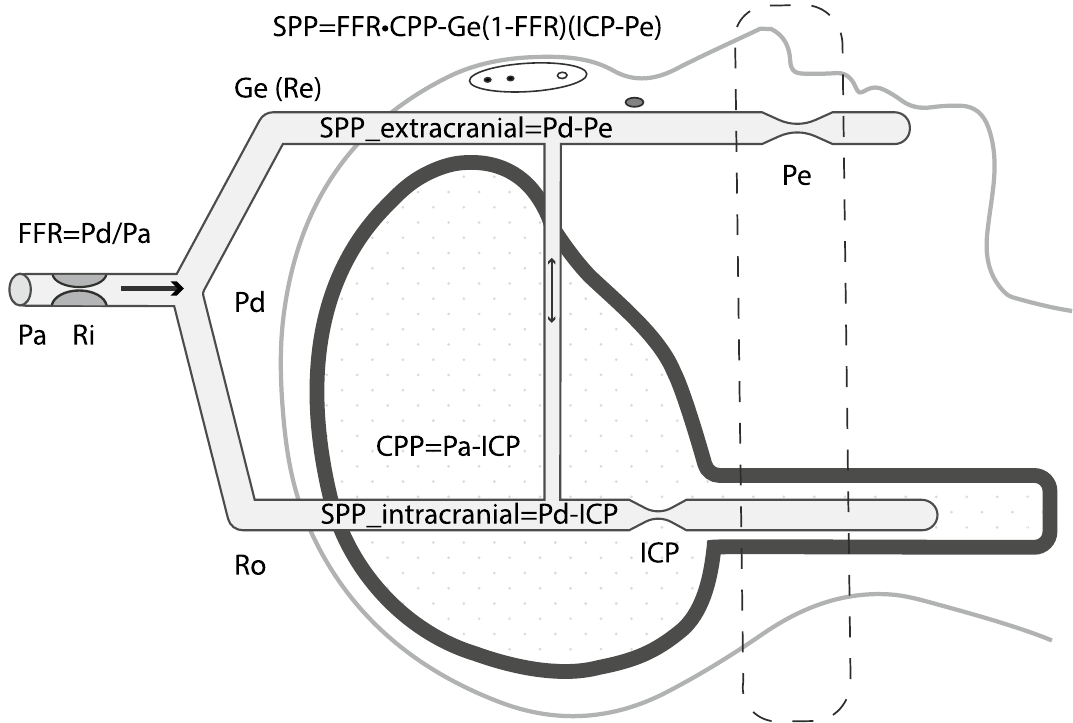
Figure 1. Schematic representation of intra-extracranial flow distribution. Despite the multitude of arterial and venous extra-intracranial supply pathways and anastomoses, all blood flow to the head is divided into the intracranial and extracranial, with corresponding compartmental pressures ICP and Pe. Extracranial compartment pressure is either atmospheric or venous (whichever is higher). Common inflow pressure Pd (equilibrated at the circle of Willis) is lower than systemic pressure Pa due to the common inflow resistance Ri—which determines fractional flow reserve- FFR. Pd can be estimated by measuring pressure in the intra- extracranial collateral—we measured supraorbital artery pressure using maximal photoplethysmographic oscillation criteria. Segmental perfusion pressure of the intracranial compartment (SPP = Pd–ICP), rather than cerebral perfusion pressure (CPP = Pa–ICP), is the driving gradient for the cerebral blood flow. SPP_ intracranial was expressed using Starling resistor equations for the intra and extra-cranial compartments: SPP = FFR*CPP-Ge*(1 − FFR)*(ICP–Pe). If FFR is less than 1, and ICP > Pe, Pd is reduced not only by the inflow resistance (first term), but also by the additional pressure drop due to the flow diversion from the intracranial compartment (Ro) to the extracranial compartment (Re) with relative conductance Ge. The second term in the equation (intra-extracranial steal) reverses to the extra-intracranial augmentation when Pe > ICP. To investigate extra-intracranial flow distribution in a healthy volunteer, we manipulated extracranial outflow pressure Pe. Antegrade flow in the supraorbital artery (intra-extracranial steal) was reversed during stepwise inflation of the infraorbital cuff demonstrating the feasibility of intracranial blood flow